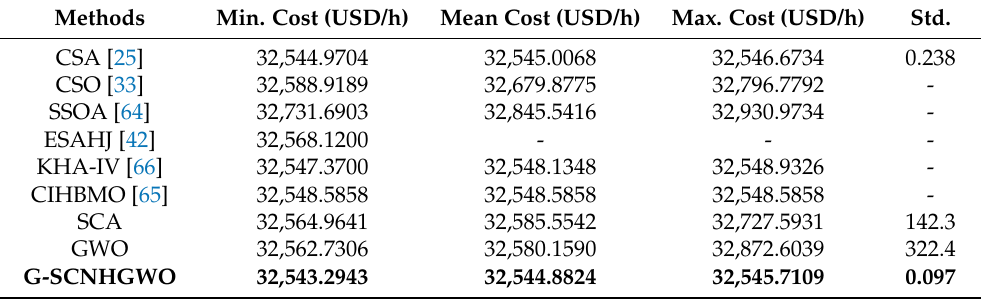
Table 5. The statistical indices of optimal results obtained by different algorithms in Case B-type 1.